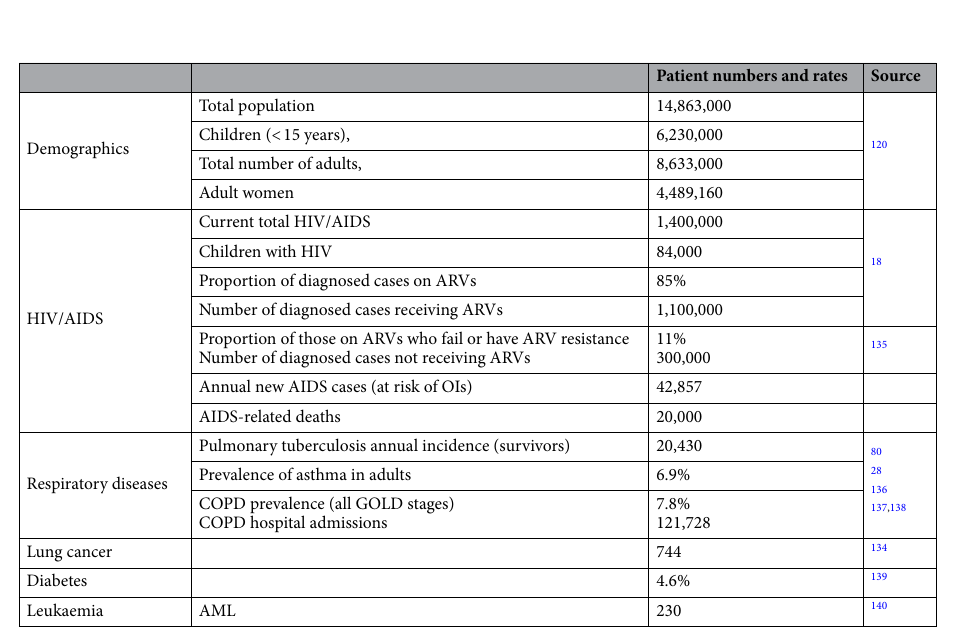
Table 4. Country’s profile. Populations and rates required to calculate burden fungal-related diseases in Zimbabwe. COPD chronic obstructive pulmonary disease, GOLD Global initiative for Obstructive Lung Disease, ARV antiretroviral, OI opportunistic infection, AML acute myeloid